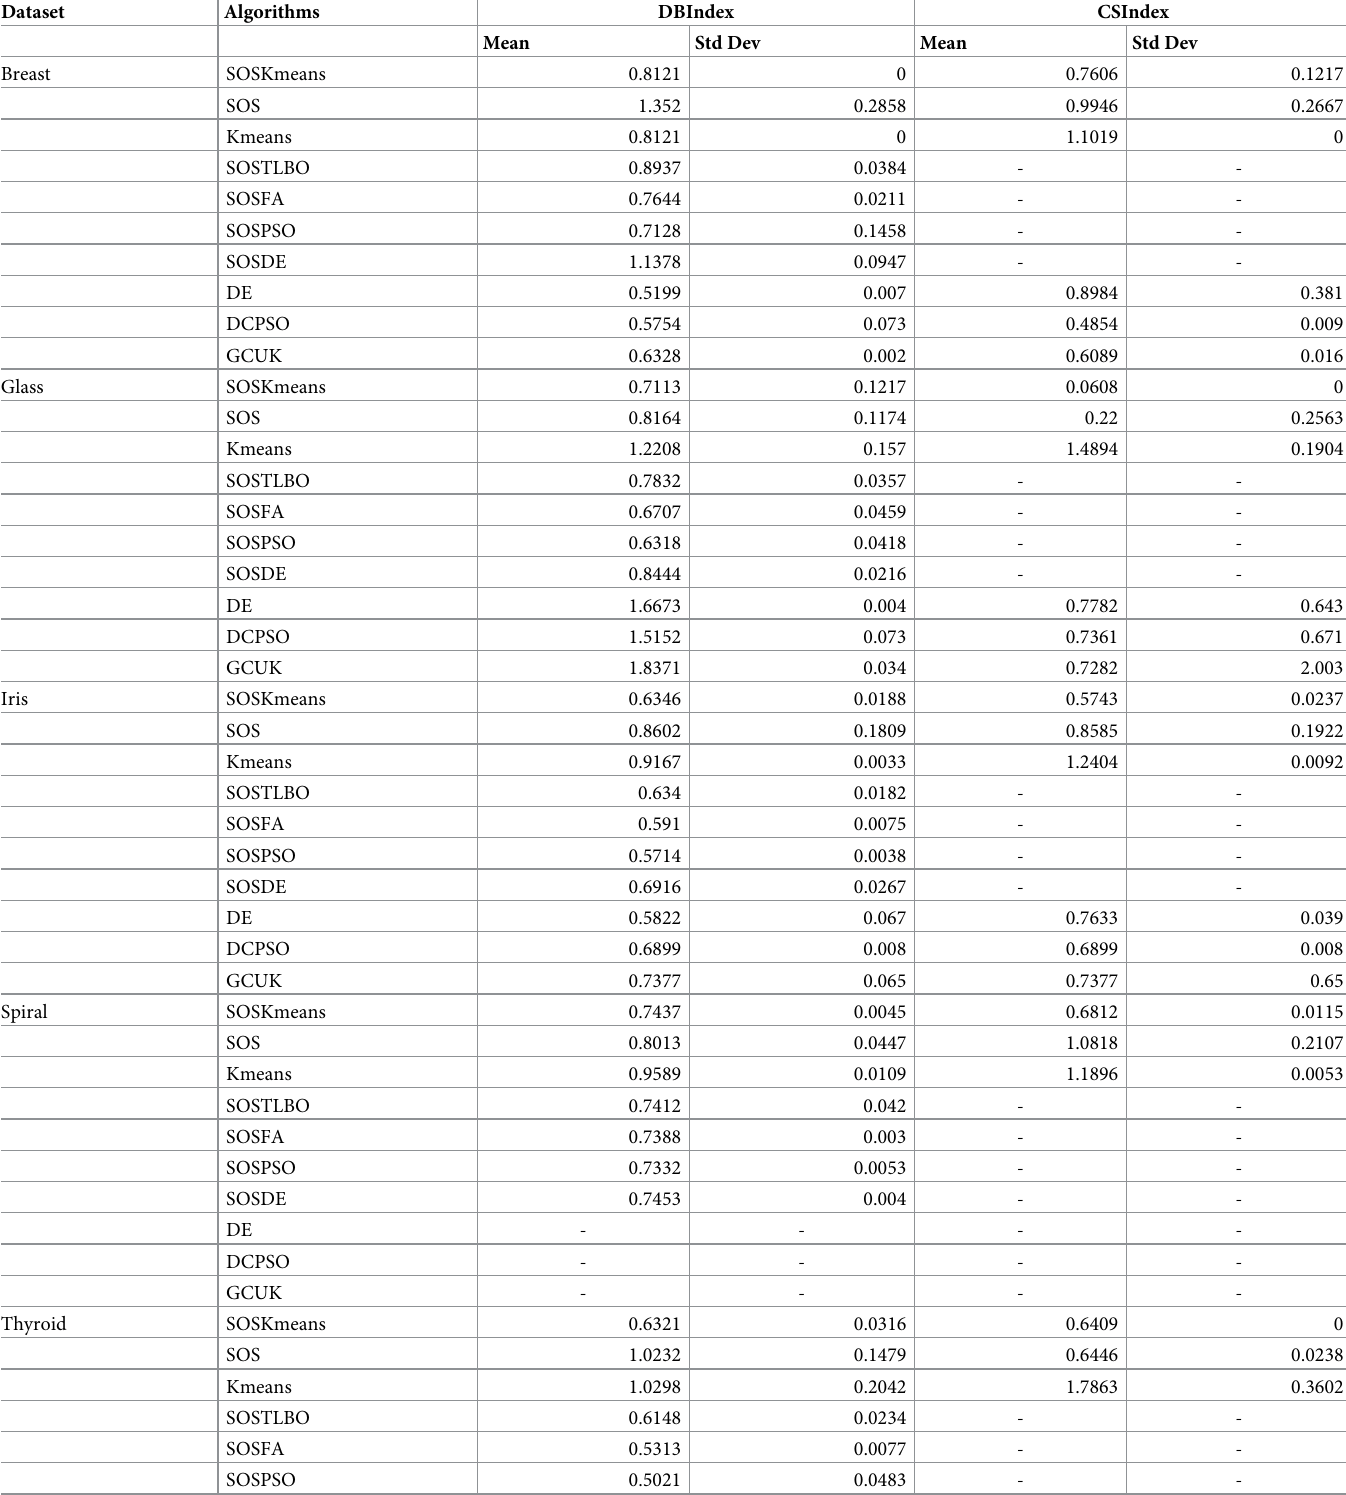
Table 7. SOSK-means results compared with results from existing algorithms in the literature.